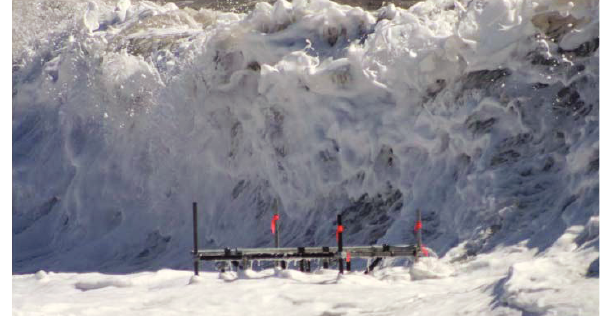
Figure 4. The instrument frame in an energetic shorebreak.